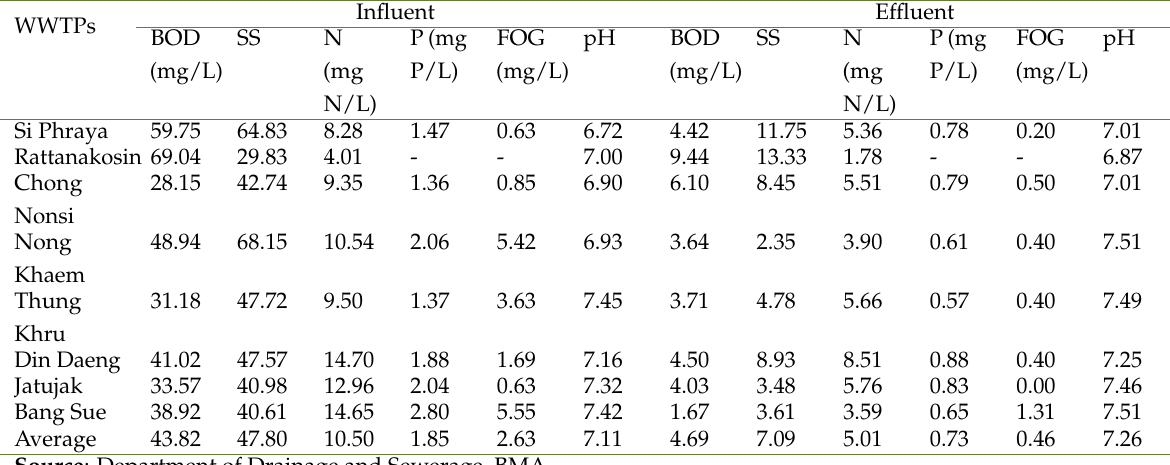
Table 3. Characteristics of Influent and effluent wastewater of the BMA WWTPs in 2021